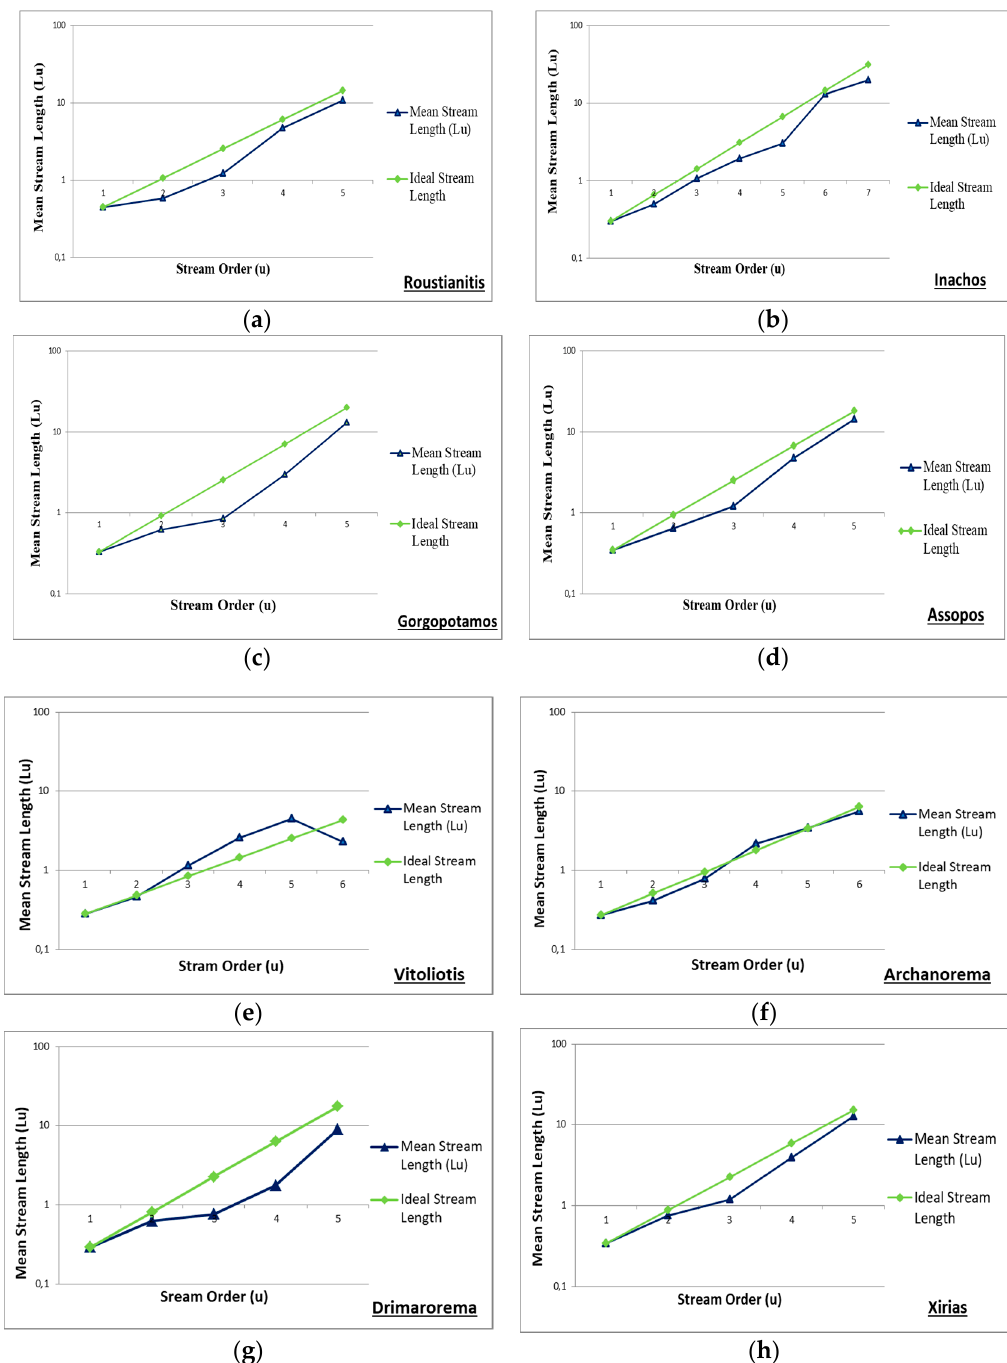
Figure 7. Diagrams showing the streams’ mean length deviation from the ideal values of Horton’s law for the four south sub-catchments, ( a ) Roustianitis, ( b ) Inachos, ( c ) Gorgopotamos, ( d ) Assopos and the four north sub-catchments ( e ) Vitoliotis, ( f ) Archanorema, ( g ) Drimarorema and ( h ) Xirias. The Roustianitis catchment displays high mean elevation (998.7 m); total relief (1484.1 m); − 1 − 1 mean slope (40%); relief ratio (101.58 m km ) and slope index (95.75 m km ) values. The length–width ratio appears equally high, characterizing catchments with elongated shape, a ff ected by the neo-tectonic activity of the area. Inachos shows the highest mean elevation (1155.4 m) and total relief (2203.6 m) − 1 values of all the study area sub-catchments. The mean slope (42%), relief ratio (75.44 m km ) and − 1 slope index (72.49 m km ) values are also high. The form factor, circularity ratio and